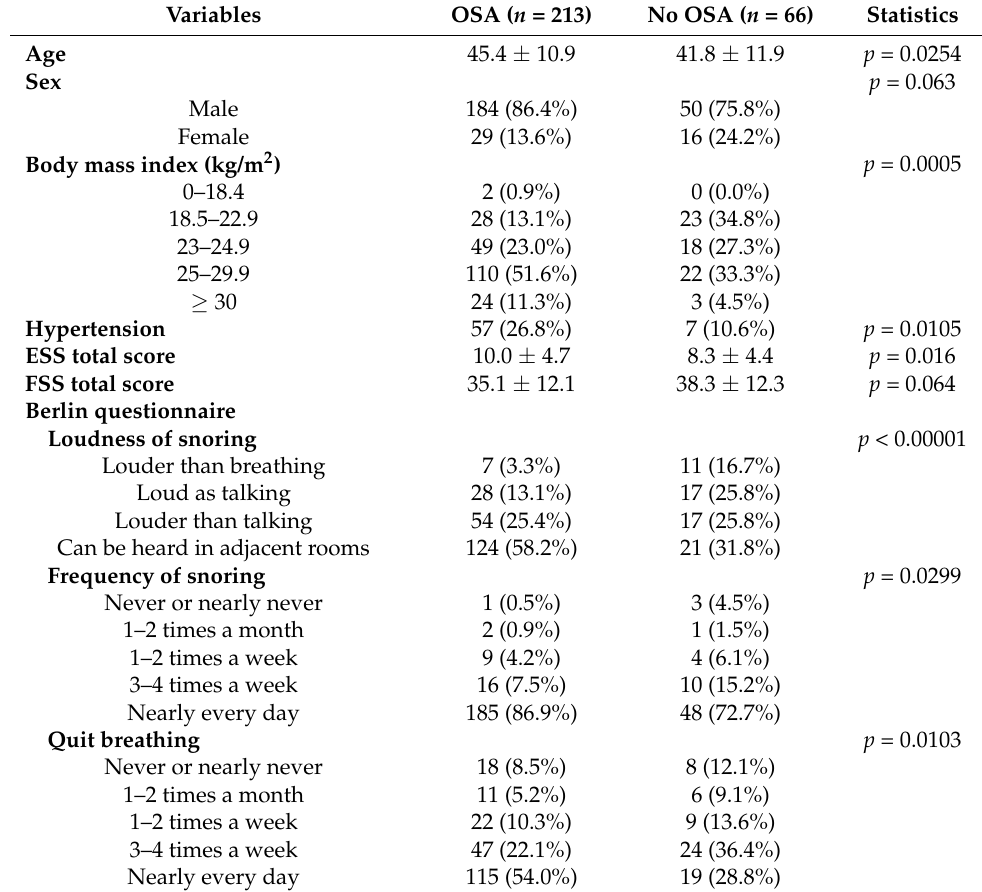
Table 2. Characteristics of the participants in the OSA and no OSA groups and the comparison between the groups.